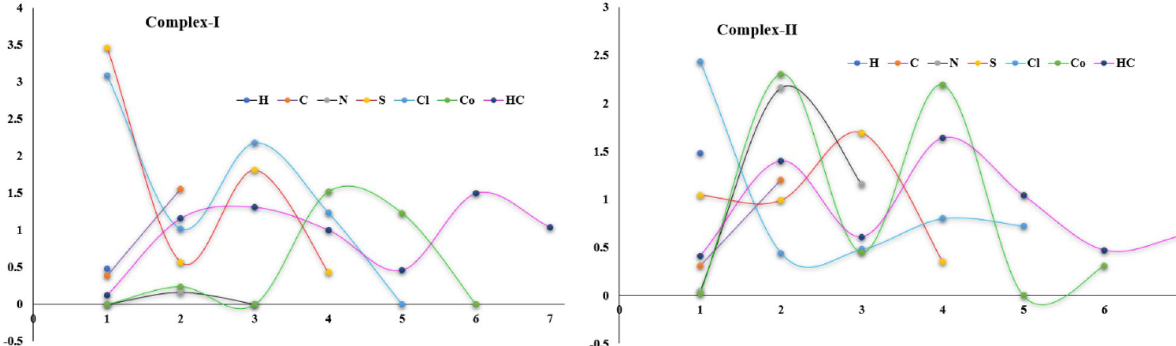
Figure 12. The correlation map shows the enrichment ratio of both complexes.